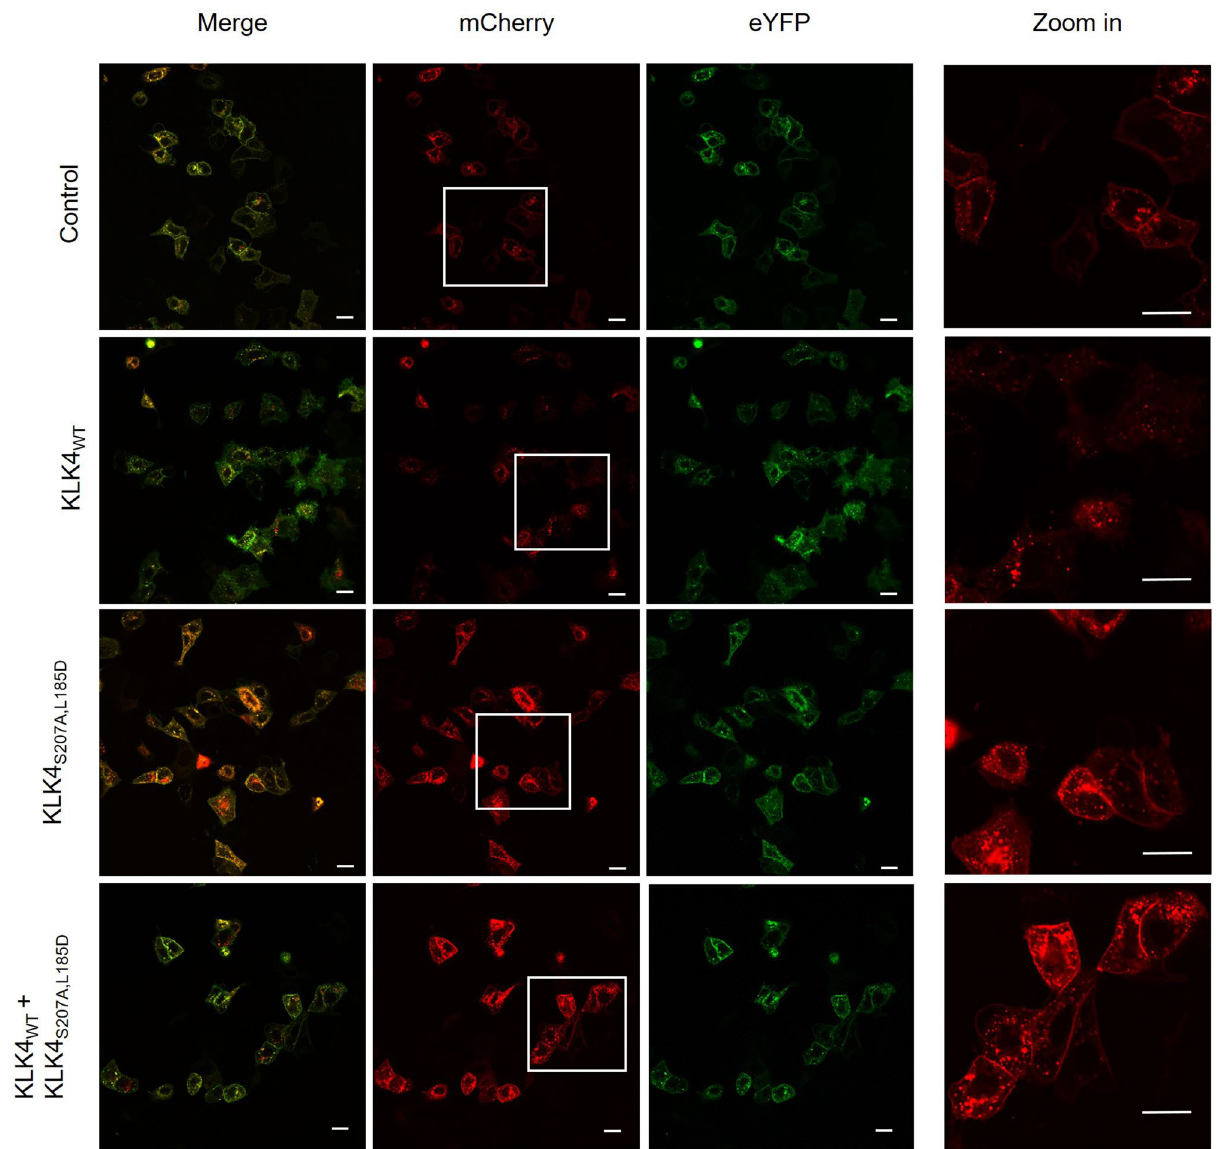
Figure 3. Confocal microscope images of MCF7 breast cancer cells, expressing the mCherry-PAR1-eYFP construct in the presence or absence of KLK4 WT and KLK4 L185D,S207A . The right-most column represents a zoom-in view of the white box for each row in the mCherry column and arrows point to a visible membrane mCherry (extracellular PAR1 domain) signal. The red and green channels were used to measure mCherry (extracellular PAR1 domain) and eYFP (intracellular PAR1 domain), respectively. A 20-µm scale bar is indicated as a white bar on the lower right corner of each intracellular region. In both the MCF7 and WM3682 cell lines, cleavage (activation) of PAR1 upon treatment with 100 nM KLK4 WT removed the extracellular mCherry, leaving the intracellular eYFP intact (Fig. 3 and Sup- plementary Fig. S2). As may be seen in the confocal microscopy experiments described here and as was also found in previous studies (e.g. 32 ), the released mCherry tag appeared to be internalized into the cells. This find- ing stands in contrast to that for the untreated cells, for which the extracellular domain (mCherry) underwent only a minor cleavage, probably caused by endogenously released extracellular proteases. Notably, addition of 200 nM KLK4 S207A,L185D together with 100 nM of the catalytically active KLK4 WT inhibited the cleavage of mem- brane PAR1. In a complementary, more quantitative, experiment using fluorescence spectroscopy, we showed that treat- ment of WM3682 cells overexpressing fluorescently labeled PAR1 with a mixture of KLK4 WT and KLK4 S207A,L185D resulted in a significant, dose-dependent inhibition of PAR1 cleavage in comparison with treatment with KLK4 WT alone (Fig. 4). Of particular importance, in the absence of KLK4 WT , inhibition by KLK4 S207A,L185D of the PAR1 cleavage, presumably mediated by endogenously produced microenvironment proteinases, was also observed.